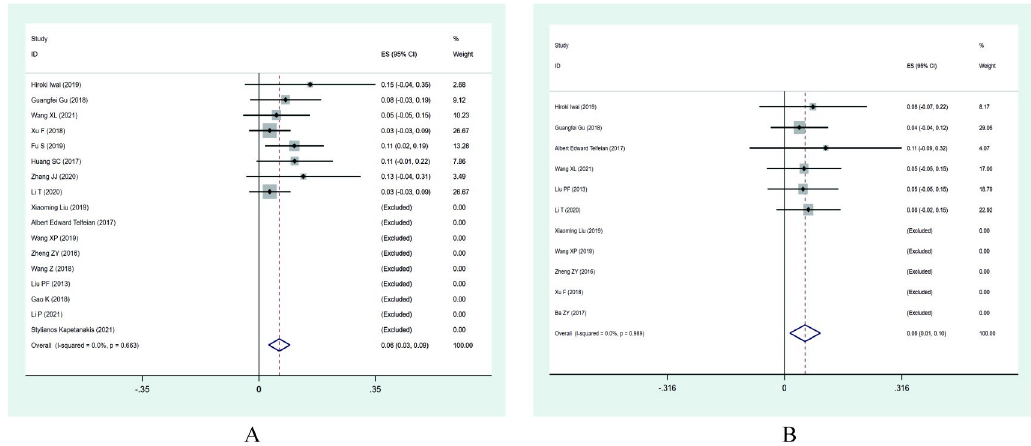
Fig 7. Forest plot of complications and recurrence rates after PES. (A) Complications; (B) Rescurrence rates.